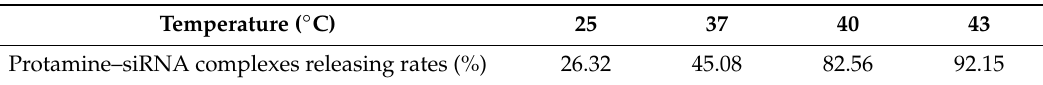
Table 2. The cumulative releasing rates of protamine-siRNA complexes from the TSPMAHs versus temperatures. Temperature ( ◦ C) Protamine–siRNA complexes releasing rates (%)